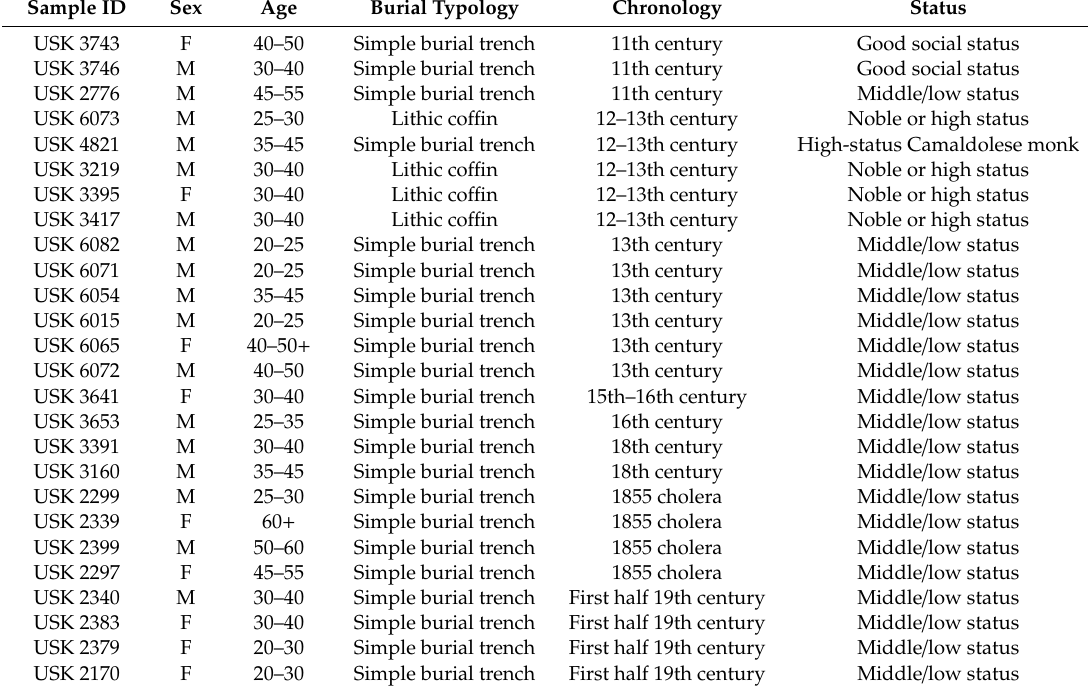
Table 1. Samples of dental calculus from Badia Pozzeveri. ID—identifier; F—female; M—male. Sample